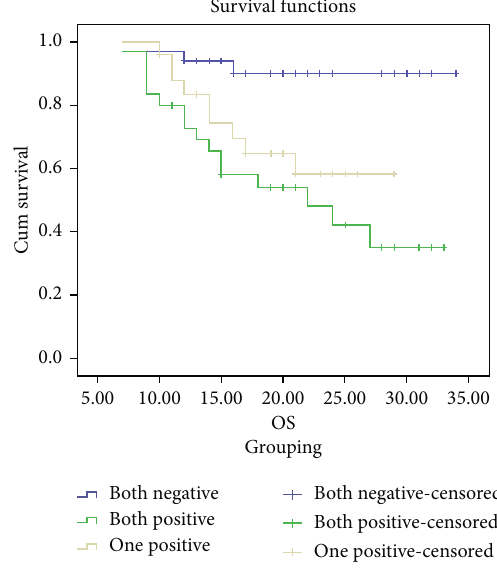
Figure 4: Kaplan-Meier OS analysis of studied cases according to MALAT-1 and BACH expression.